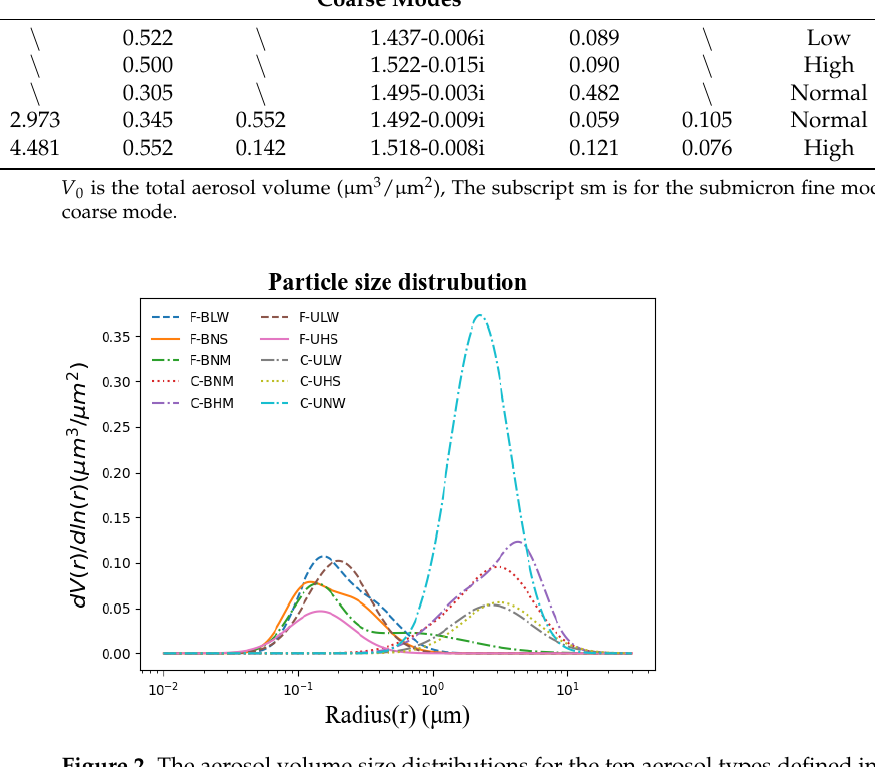
Figure 2. The aerosol volume size distributions for the ten aerosol types defined in Table 4.